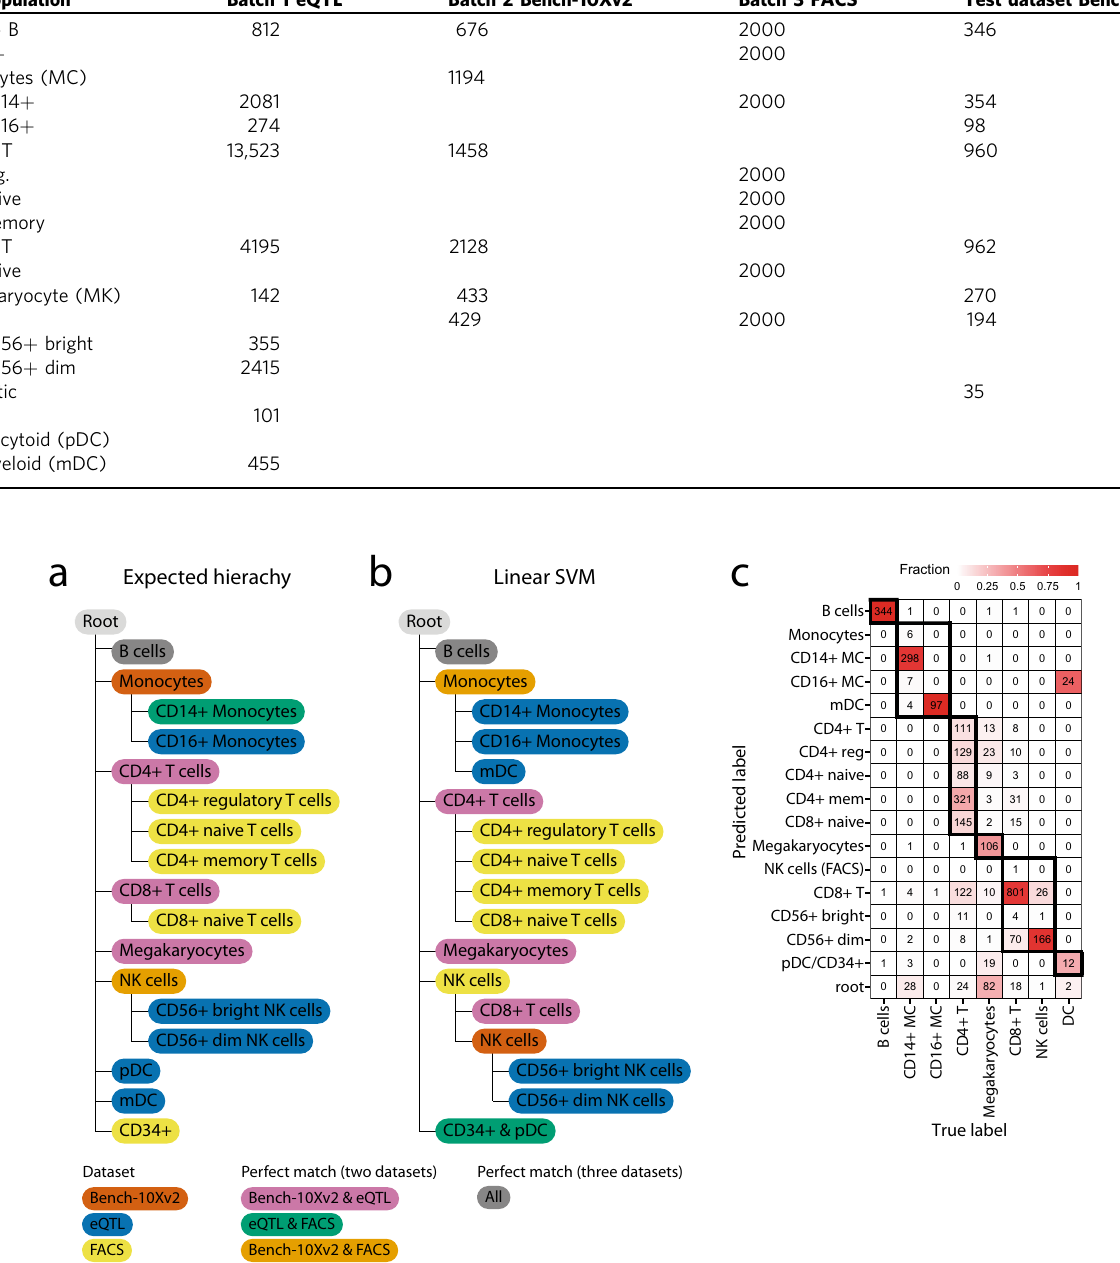
Fig. 5 PBMC inter-dataset evaluation. a Expected and b learned classi fi cation tree when using a linear SVM on the PBMC datasets. The color of a node represents the agreement between dataset(s) regarding that cell population. c Confusion matrix when using the learned classi fi cation tree to predict the labels of PBMC-Bench10Xv3. The dark boundaries indicate the hierarchy of the constructed classi fi cation with “ mural (Saunders) ” and “ vascular smooth muscle cells (Zeisel) ” , while “ pericytes (Zeisel) ” is a subpopulation of “ endothelial stalk (Saunders) ” and “ endothelial cell (TM) ” (Supplementary Figs. 22 and 23). In the UMAP embedding of the integrated datasets, the “ pericytes ” and “ brain pericyte ” are at different locations, but they do overlap with the cell populations they were matched with (Supplementary Fig. 21). This highlights the power of scHPL matching rather than name-based matching.